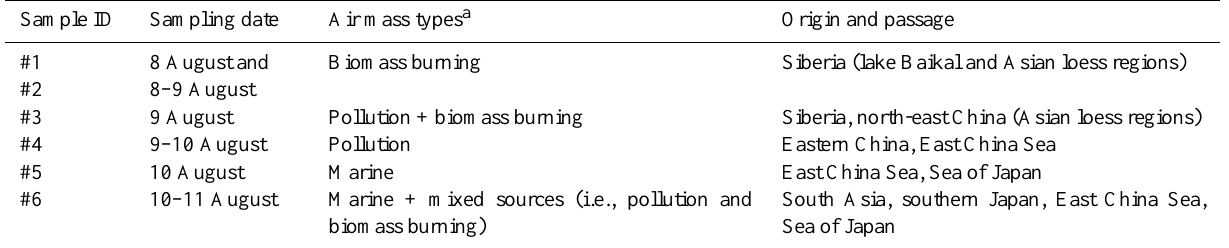
Table 1. Description of air mass types, source regions, and their passages for the Sapporo aerosol samples collected in summer